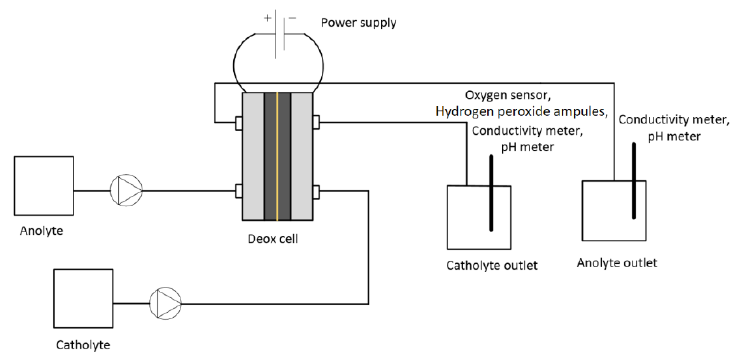
Figure 2. Schematic diagram of the experimental set-up.